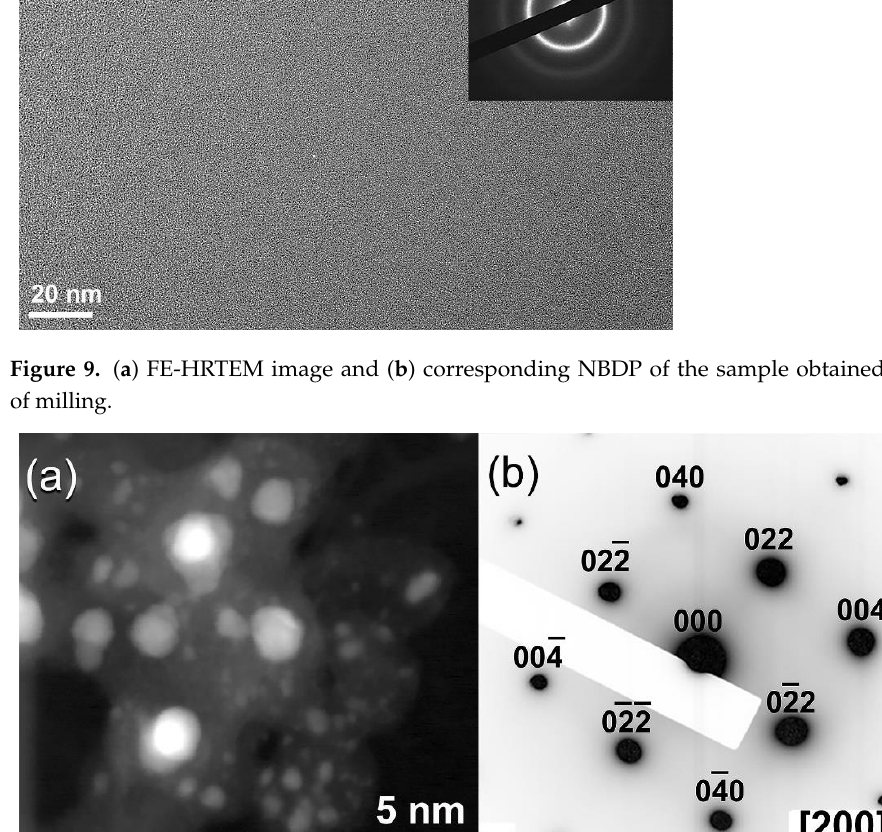
Figure 10. ( a ) Dark field image (DFI), and ( b ) corresponding NBDP of the sample obtained after 28 h of milling.